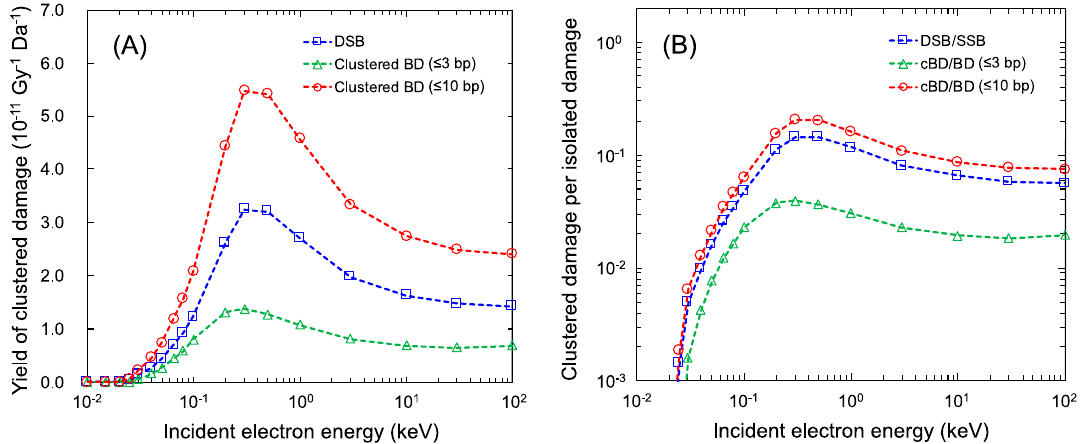
Figure 3. Yields of complex damage for mono-energetic electrons: ( A ) is the yields of complex base damage (BD) for various cluster sizes; ( B ) is the yield ratio of complex damage and isolated damage (complex BD (cBD) per BD and double-strand break (DSB) per single-strand break (SSB)). The blue square is Y DSB / Y SSB for a < 10 bp cluster size, the red circle is the Y cBD / Y BD for a < 10 bp cluster size, and the green triangle is the Y cBD / Y BD for a < 3 bp cluster size.